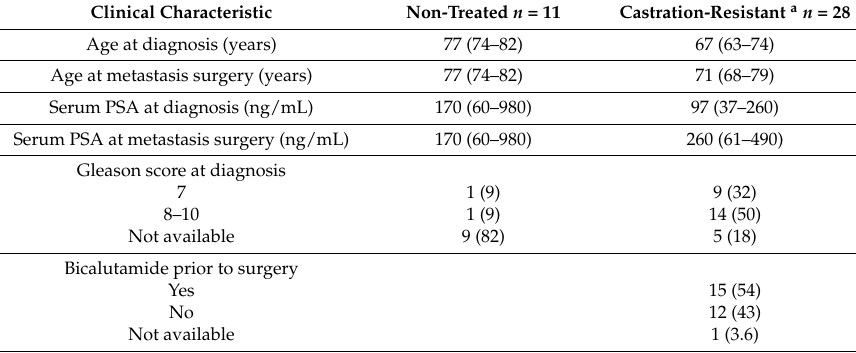
Table 1. Clinical characteristics of patients with prostate cancer who underwent surgery for metastatic spinal cord compression and where metastasis biopsies were examined by whole-genome expression analysis ( n = 28) and/or histological analysis ( n = 35).